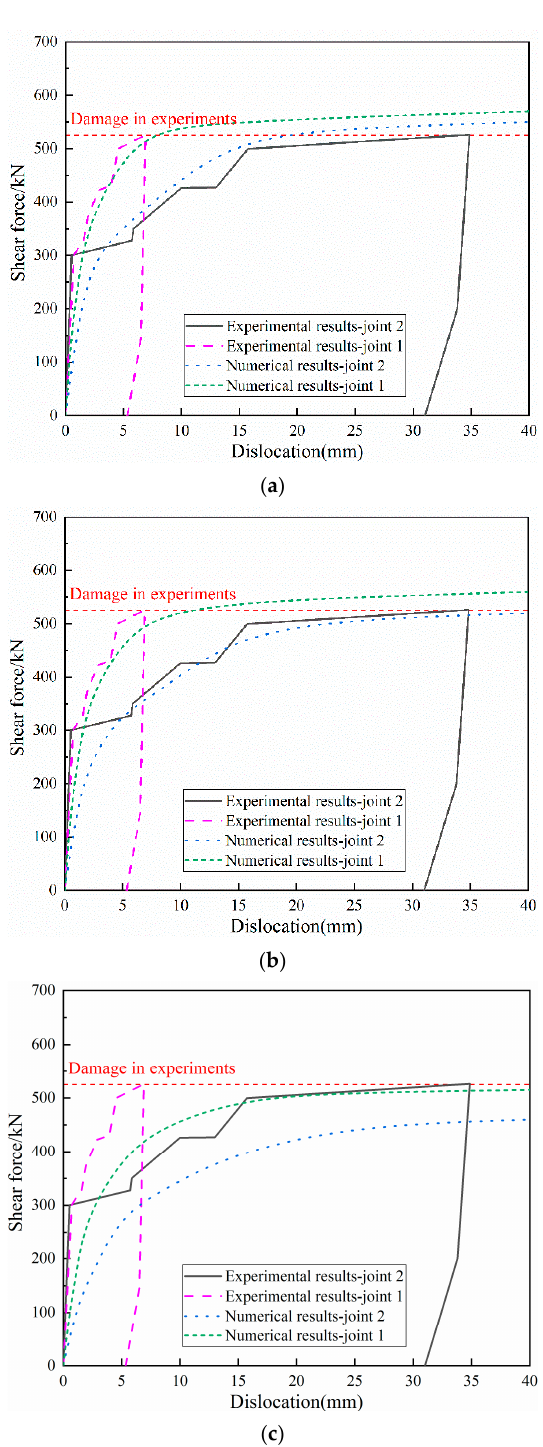
Figure 12. Comparison between numerical and experimental results. ( a ) Small mesh size. ( b ) Medium mesh size. ( c ) Large mesh